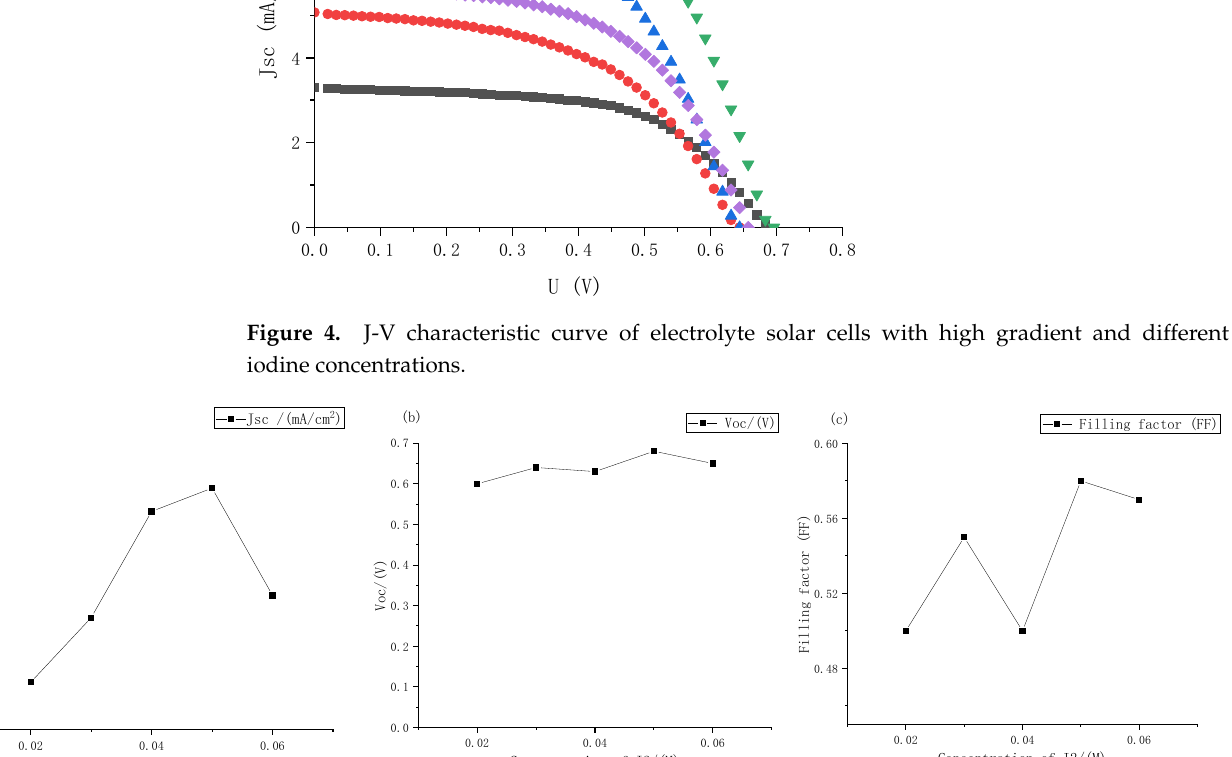
Figure 5. Performance changes in the external photoanode structure DSSC with different concen- trations of iodine under large gradient: ( a ) short circuit current density; ( b ) open circuit voltage; ( c ) filling factor.